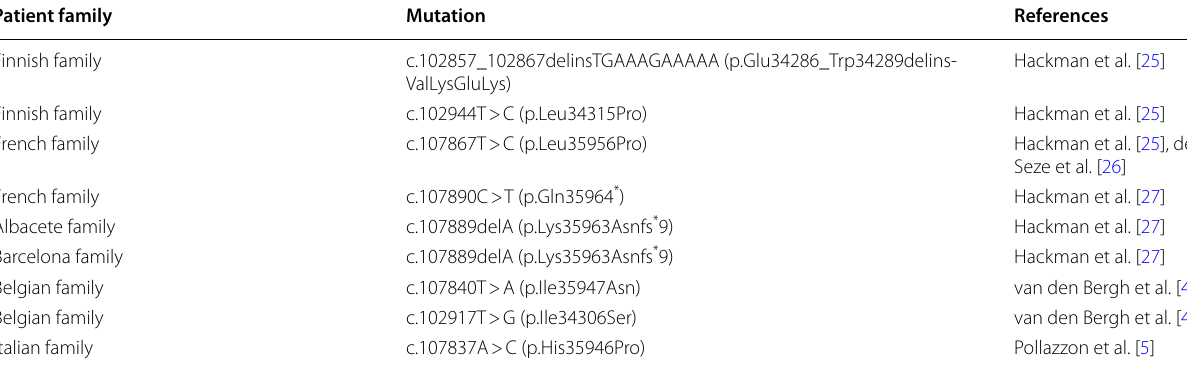
Table 2 Reported variants in TTN gene causing TMD in European